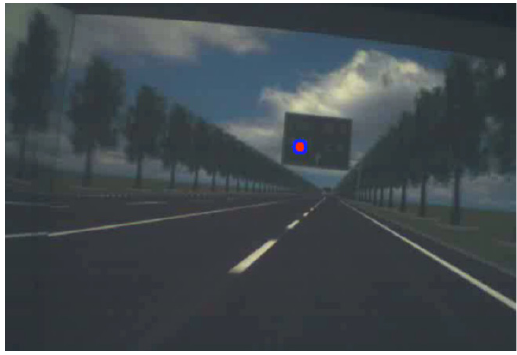
Fig.3. A screenshot from the eye tracker